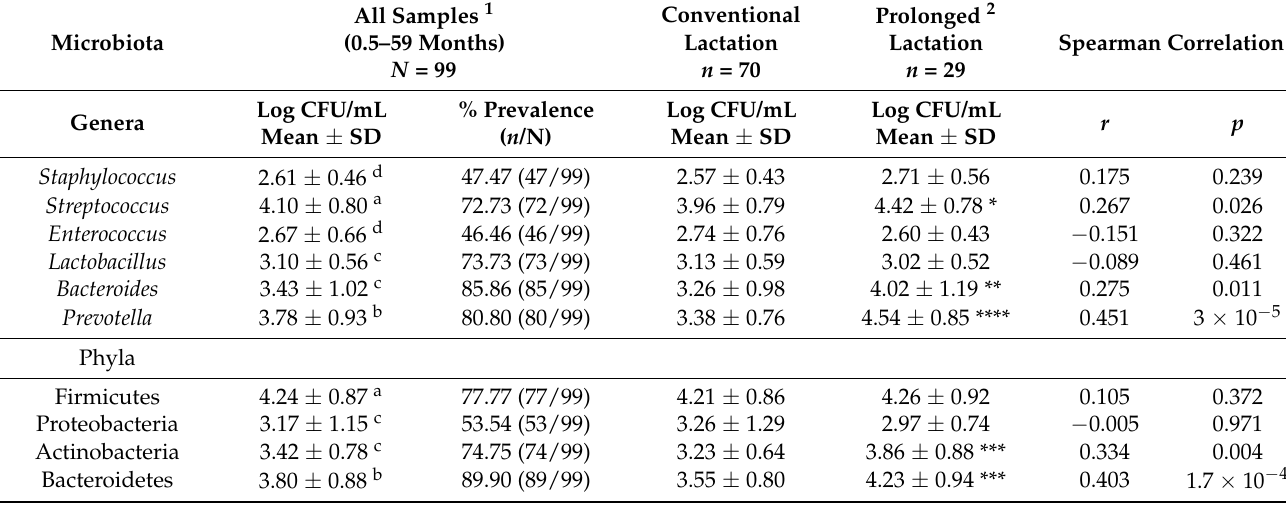
Table 4. Mean levels of bacterial groups for all Spanish breast milk samples ( N = 99) and differences between conventional (<6 months, n = 70) and prolonged ( ≥ 6 months, n = 29) lactation; correlations between lactation time and bacterial abundances in breast milk.